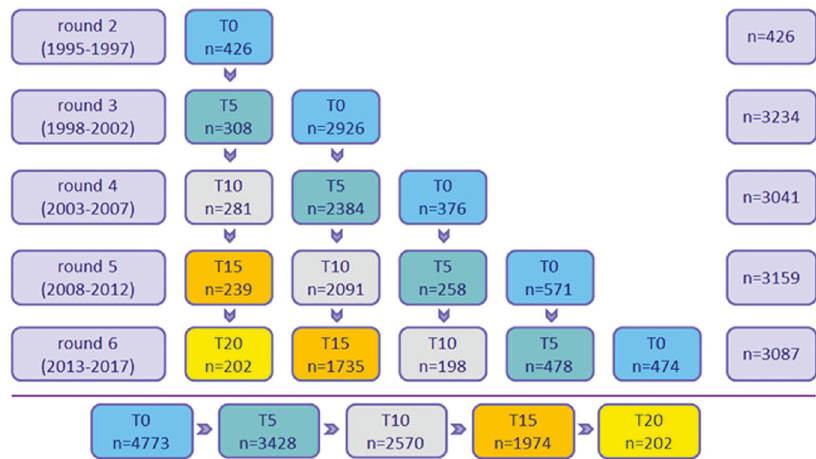
Fig. 1 Overview of cognition measurements (T0-T20) through rounds 2 – 6 in the Doetinchem Cohort Study. This fi gure shows the number of participants with one or more cognition measurements (from T0 up to T20 (time in years)) through rounds 2 – 6 of the Doetinchem Cohort Study (DCS) during the 20-year follow-up. Note: This fi gure includes all participants with cognition measurements in the DCS. In the present study, part of these participants were excluded (see Supplementary Fig. 1). T0 = blue, T5 = green, T10 = gray, T15 = orange, T20 =